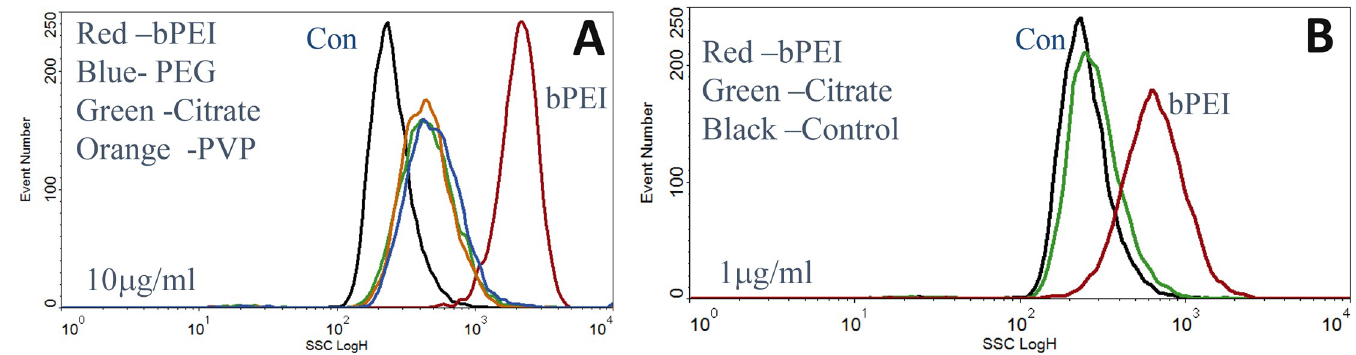
Fig 2. SSC measurements of AgNP-bPEI treated cells compared to other AgNP treated cells. Comparison of SSC of the four AgNP compounds at 10 μ g/ml A, left and 1 μ g/ml B, right. The AgNP-bPEI showed higher values suggesting greater accumulated than the other compounds at 1 μ g/ml and 10 μ g/ml.